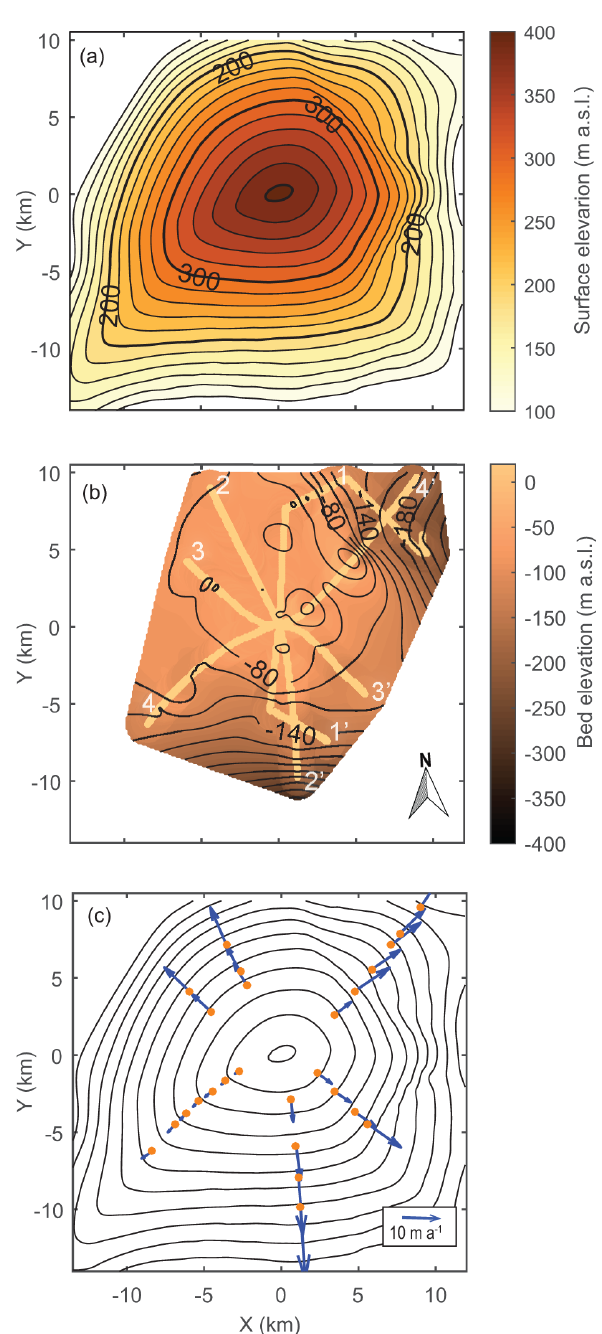
Figure 3. Ice-rise topography and flow velocities. The local coordi- nates are parallel to the polar stereographic coordinates EPSG3031 and centred at the ice-rise summit. The elevations are relative to the geoid surface. (a) Surface elevation. Contour intervals are 20m. (b) Bed elevation, also with 20m contour intervals. Radar profiles used to derive the bed topography are highlighted in yellow to show the data availability. (c) Ice-flow velocities. Surface ice-flow veloci- ties (blue arrows originated from orange circles) overlaid on surface topography (30m contour intervals). Kinematic GPS survey loca- tions are shown in Fig. 1b. GPS stakes near the summit did not give significant results and thus are not shown